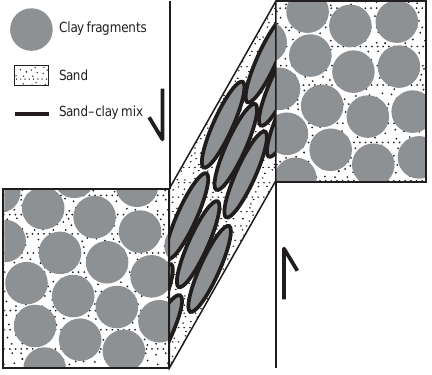
Figure B1. Concept of the simulation model testing the effect of mixing rate and clay fragment size on grain-scale mixing. Clay frag- ments embedded in a sand matrix are subject to simple shear. Sand– clay mixing zone around clay fragments increases with strain.